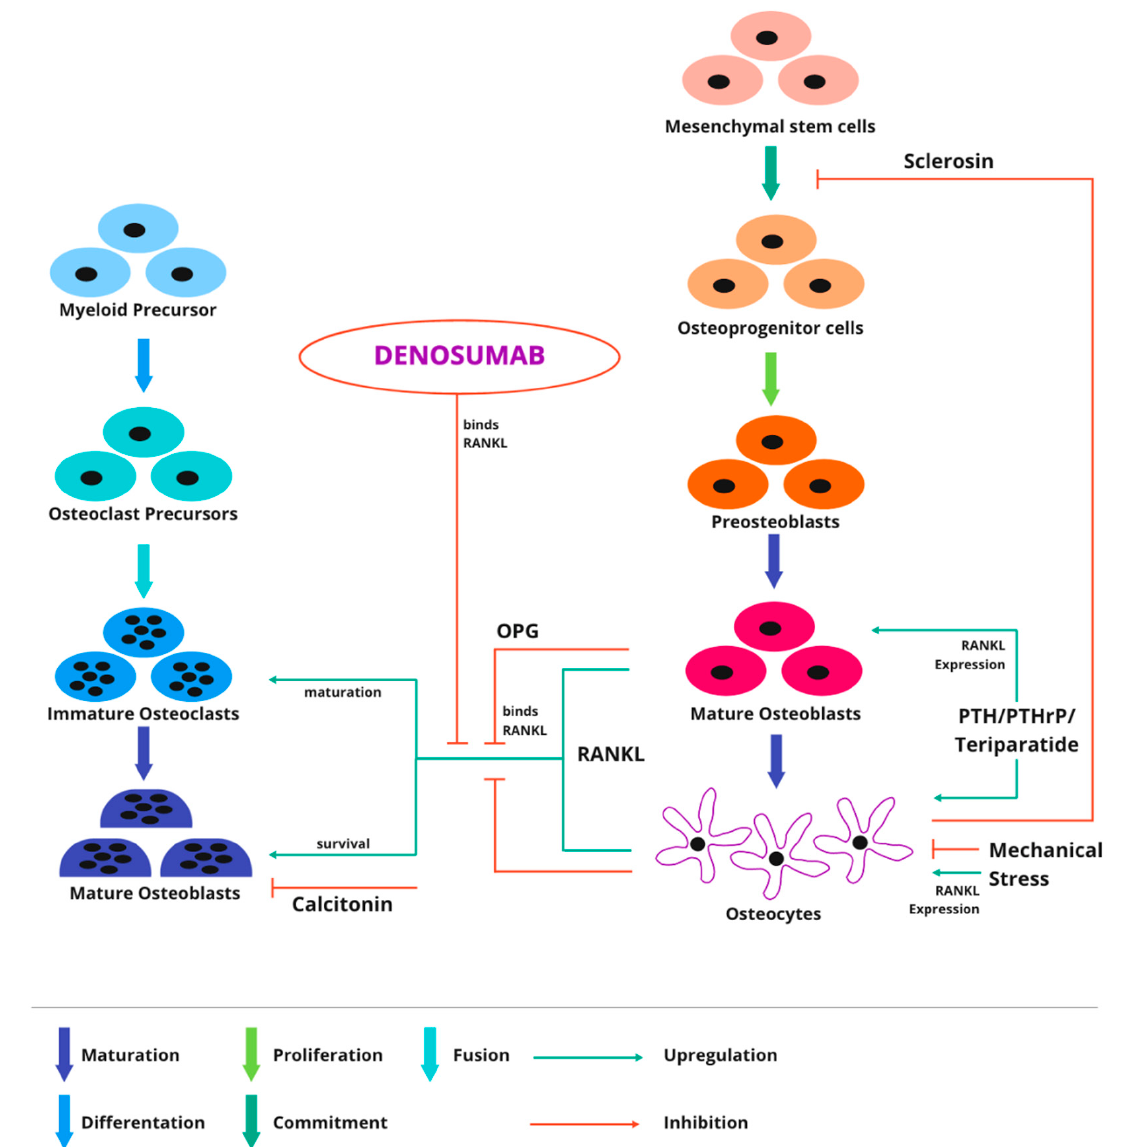
Figure 1. The basic metabolic unit’s physiologic signaling pathway and its precursors. The osteocyte is the main cell responsible for osteological metabolic regulation, as it regulates osteoblasts through sclerostin and controls osteoclasts through RANKL/OPG expression. RANKL increases osteoclastogenesis and osteoclast survival by acting on RANK. RANKL expression and signaling are critical mechanisms for activating osteoclasts and driving subsequent bone remodeling through hydroxyapatite and collagen resorption events. RANKL—nuclear factor ‐ kB receptor activator ligand; RANK—receptor located on osteoclasts; OPG—osteoprotegerin; PTH—parathyroid hormone; PTHrP—parathyroid hormone ‐ related protein.